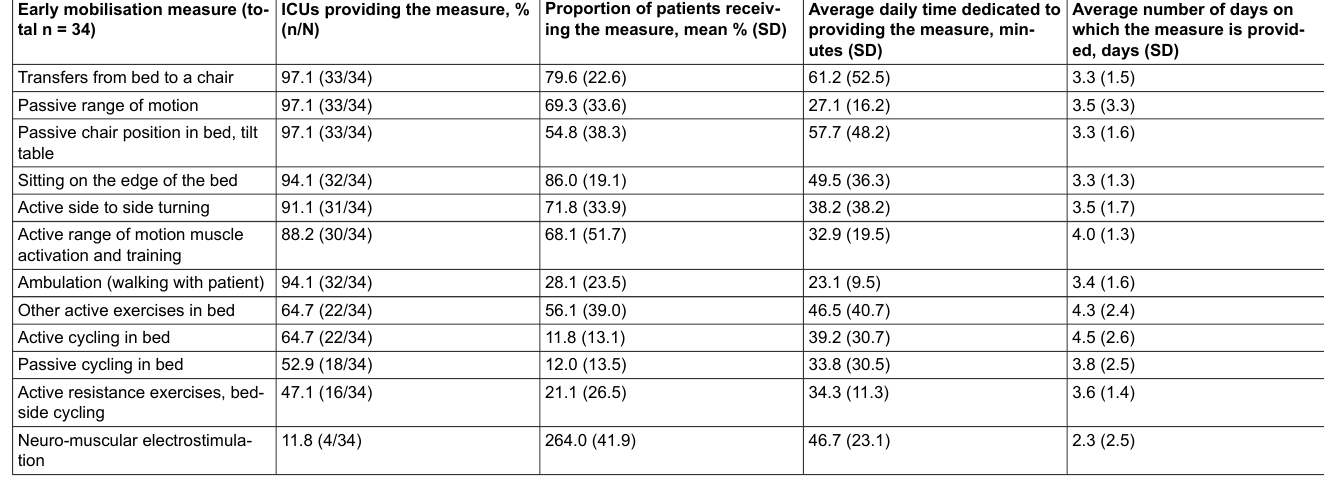
Table 3: Overview of early mobilisation measures provided in intensive care units (ICUs caring for adults only). Early mobilisation measure (to- tal n =